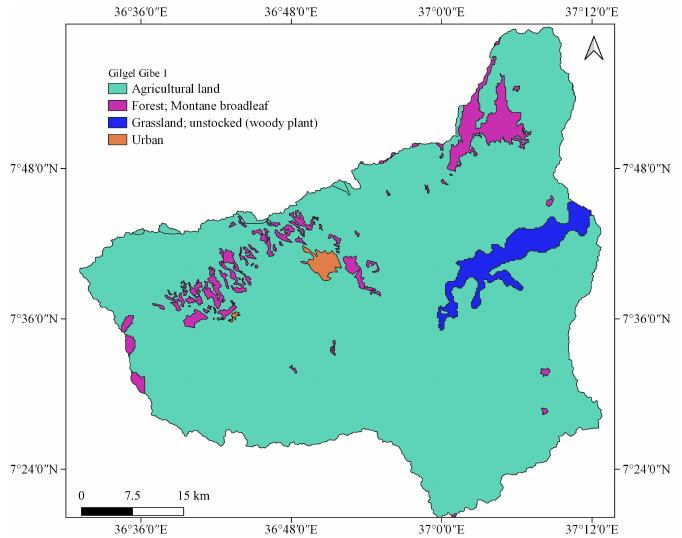
Figure 16. Land use map of the Gilgel Gibe 1 Watershed from 2010 to